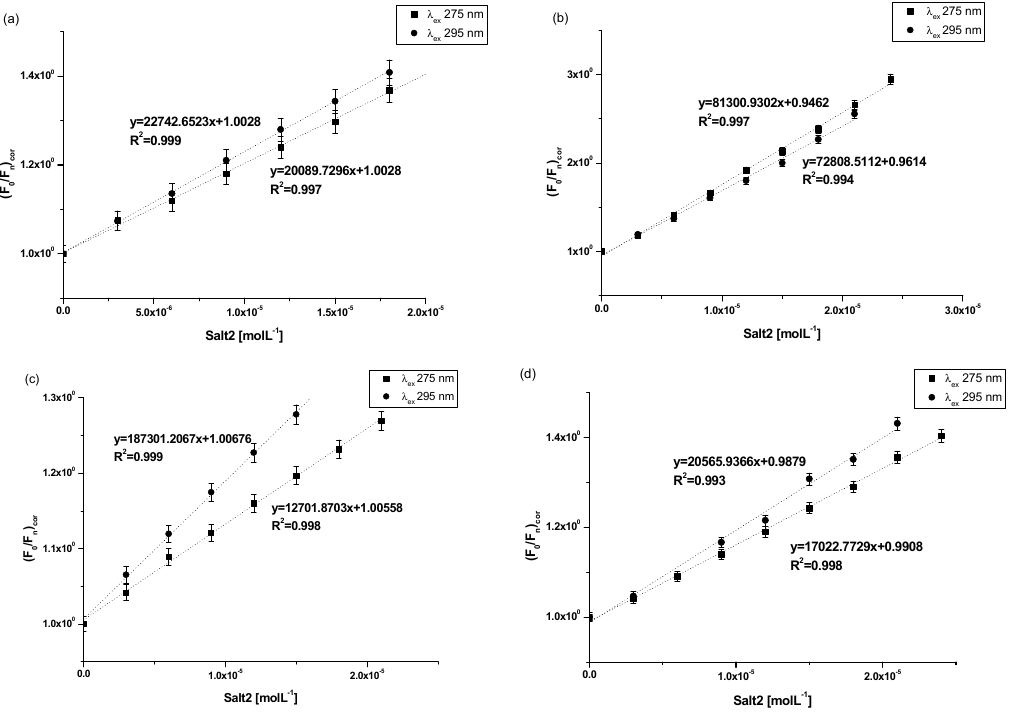
Figure 4. Stern–Volmer plots for ( a ) 3·10 − 6 mol·L − 1 HAS, ( b ) 3·10 − 6 mol·L − 1 AGP, ( c ) 3·10 − 6 mol·L − 1 HGG and ( d ) 3·10 − 6 mol·L − 1 CNS in the presence of Salt2 at increasing concentration ( λ ex 275 nm and λ ex 295 nm).